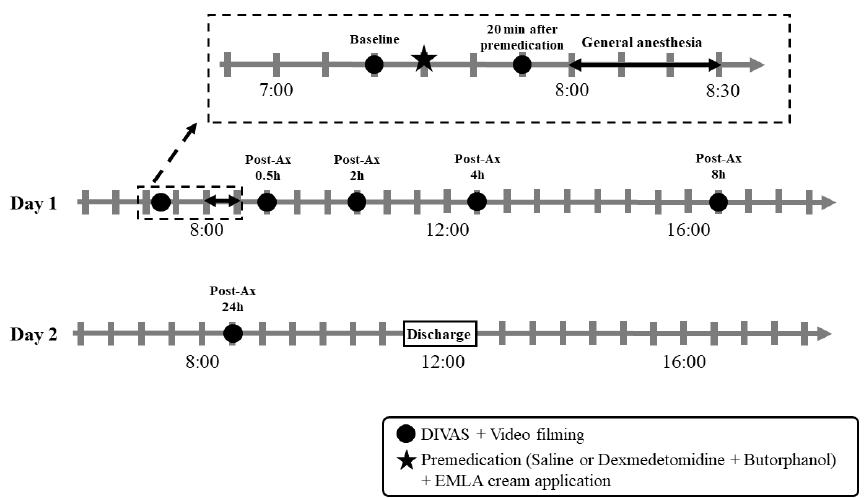
Figure 1. Schematic of time points for procedures and real-time assessment of sedation (dynamic interactive visual analog scale; DIVAS) and video recording. The line inside the dotted rectangle shows an enlarged view of the time points from the baseline to general anesthesia. EMLA: eutectic mixture of local anesthetic. Post-Ax: time-points after the end of general anesthesia.